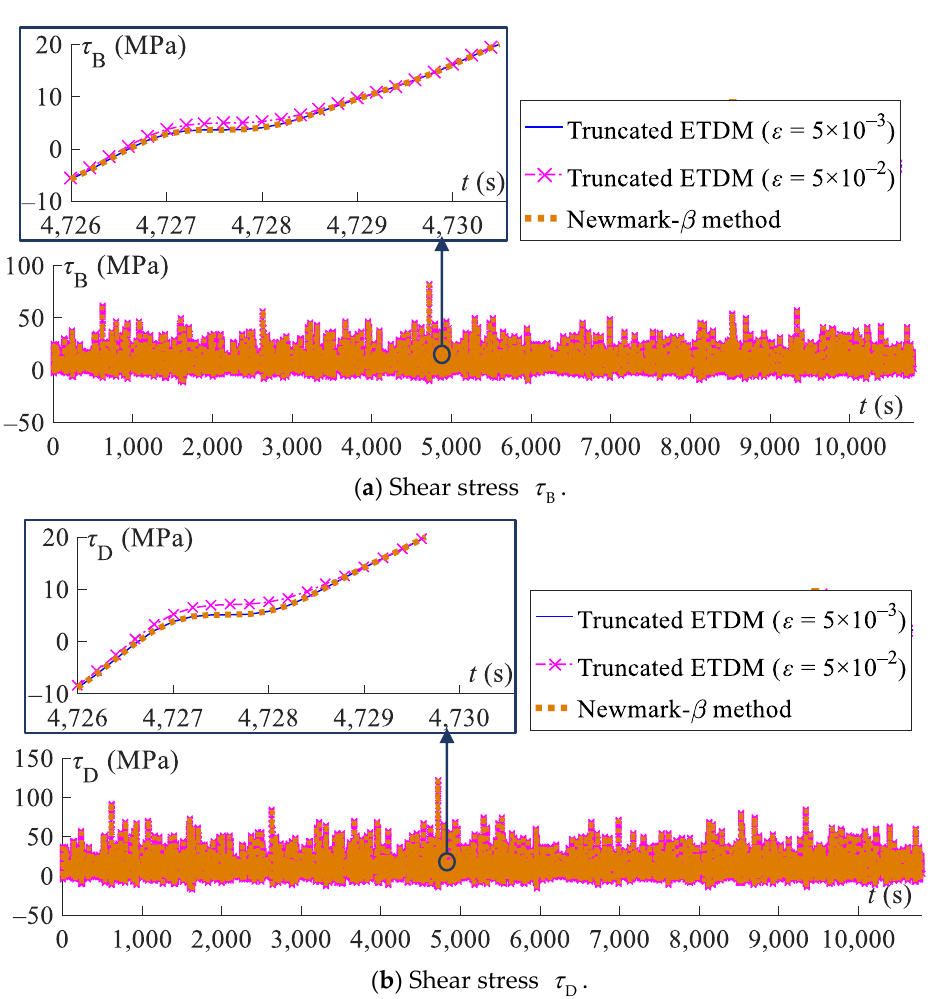
Figure 7. Normal stresses at sections B and D of the battered legs of the jacket platform.